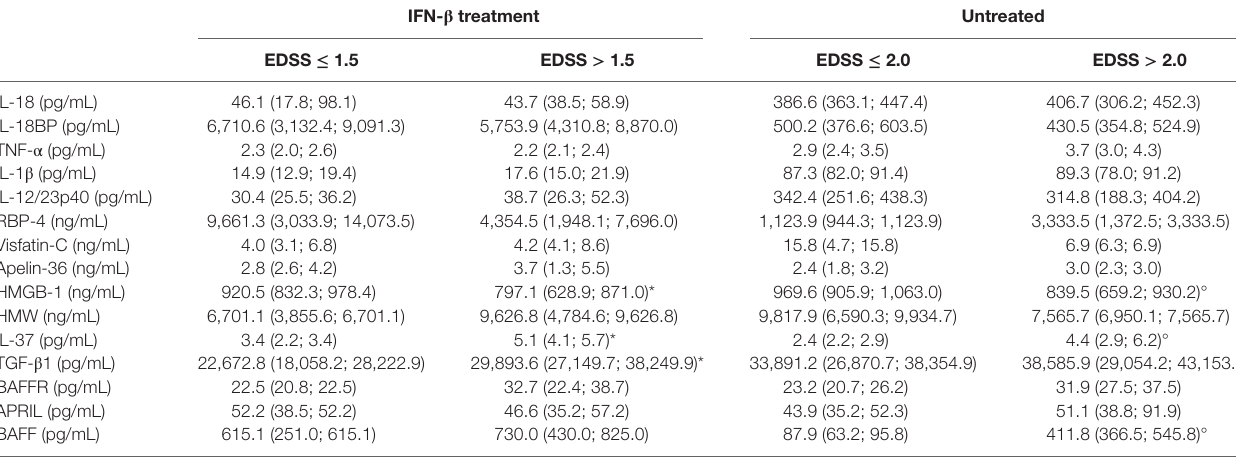
TaBle 2 | Median and interquartile range of selected